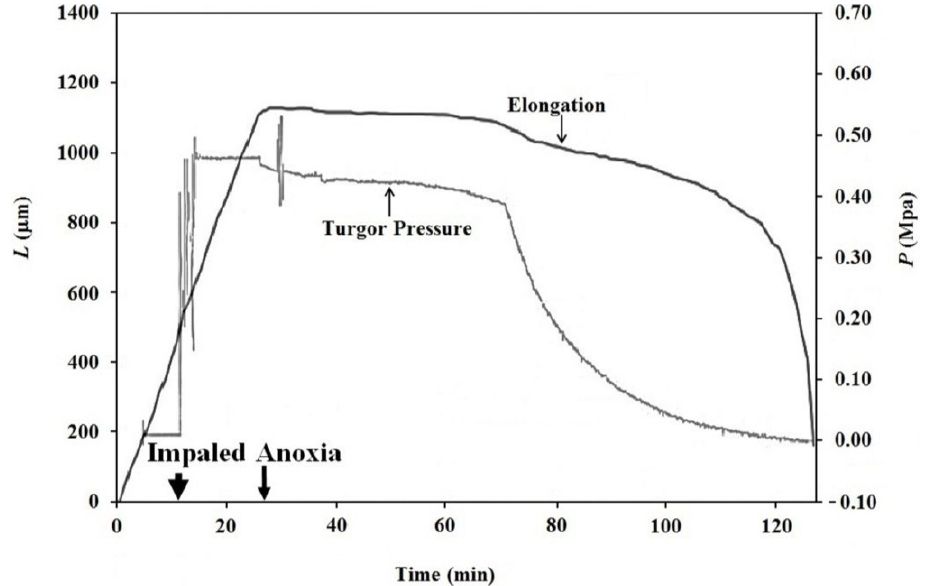
Figure 2. The change in elongation, Δ L , and turgor pressure, P , of a single Stage IV sporangiophore is plotted against the same time scale. Turgor pressure measurements begin at 10 min on the time scale and are marked by the downward pointing arrow labeled “Impaled”. The turgor pressure curve (gray) is the trace from the strip-chart recorder that measures the output of the pressure transducer in the pressure probe. The oxygen concentration is decreased from 21% to less than 1% at approximately 27 min on the time scale and is marked by the downward pointing arrow labeled “Anoxia”. The immediate small decrease in turgor pressure from a constant value indicates the exact time when the oxygen concentration was decreased to less than 1%. Jessica E.C. Olson and Elena L. Ortega (two graduate students) conducted this experiment while working in Joseph K.E. Ortega’s laboratory.